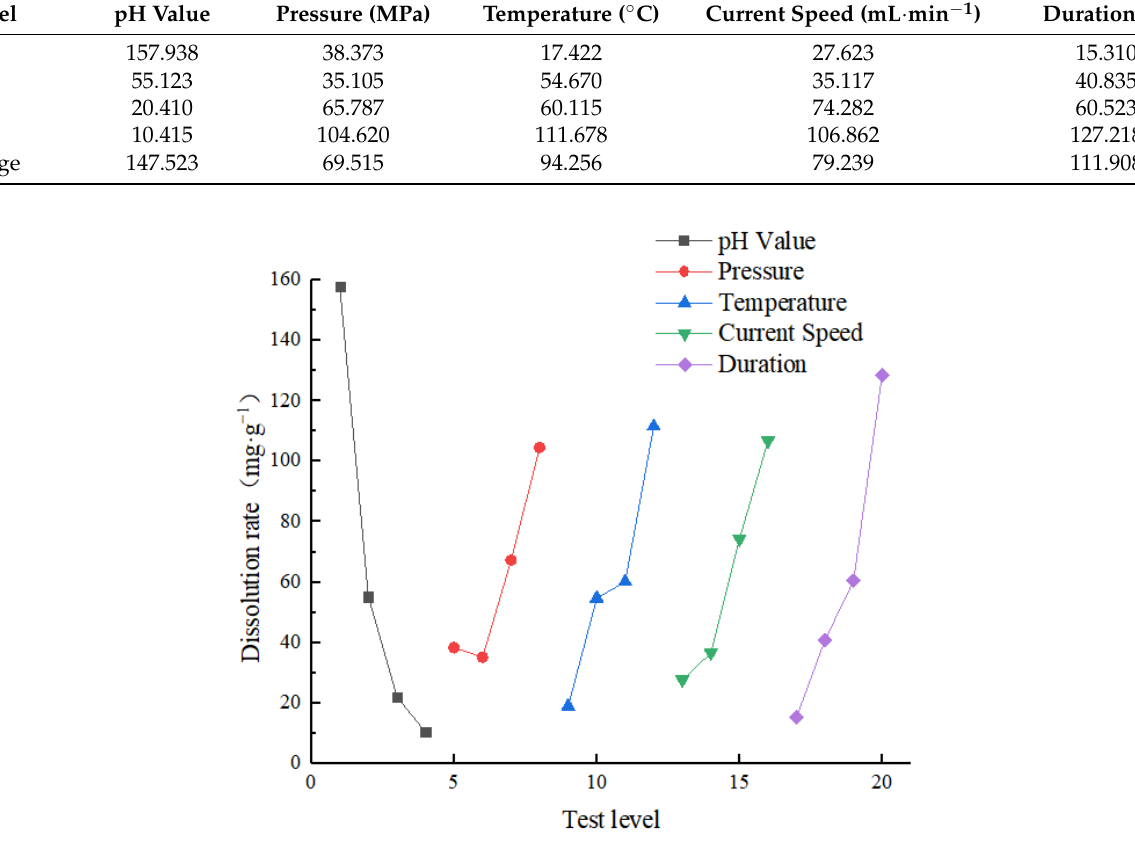
Figure 5. Sensitivity analysis of dissolution rate.